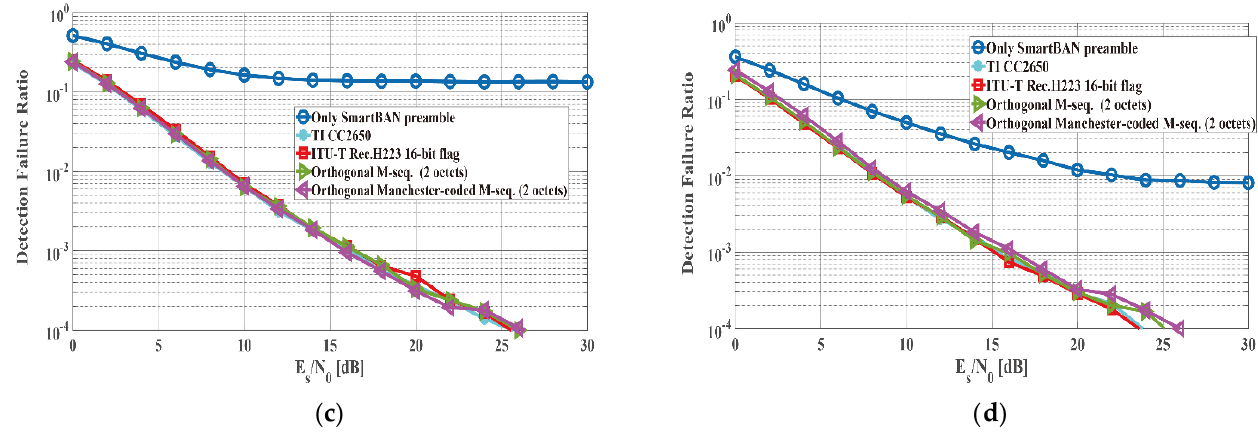
Figure 7. PLCP header detection failure ratio in the case of several modulation schemes under the IEEE channel CM3 (medium shadowing case, K = 4.5). ( a ) GFSK (SmartBAN). ( b ) QPSK. ( c ) π /4-DQPSK. ( d ) D8PSK.